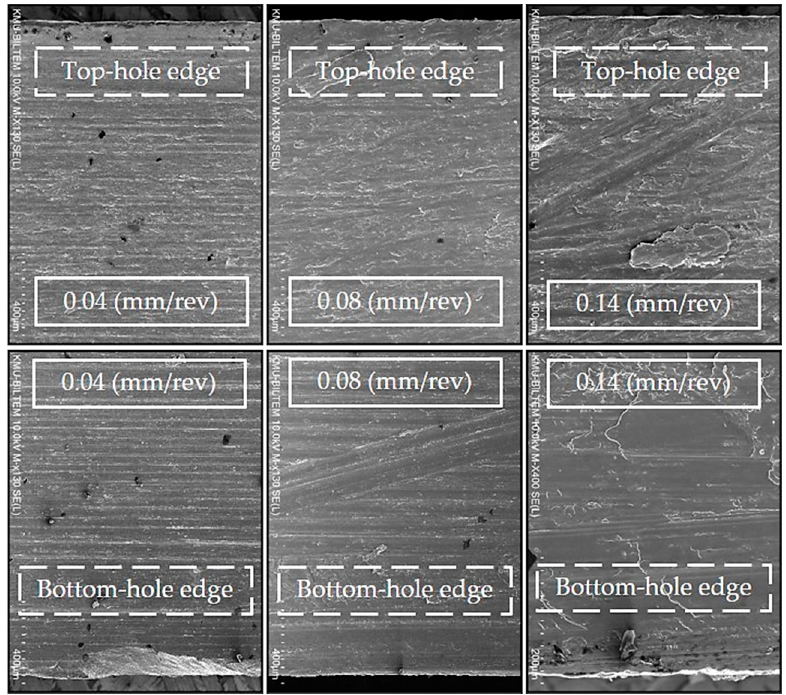
Figure 7. Borehole condition under SEM for holes drilled using 6 mm drills and 1000 rpm.